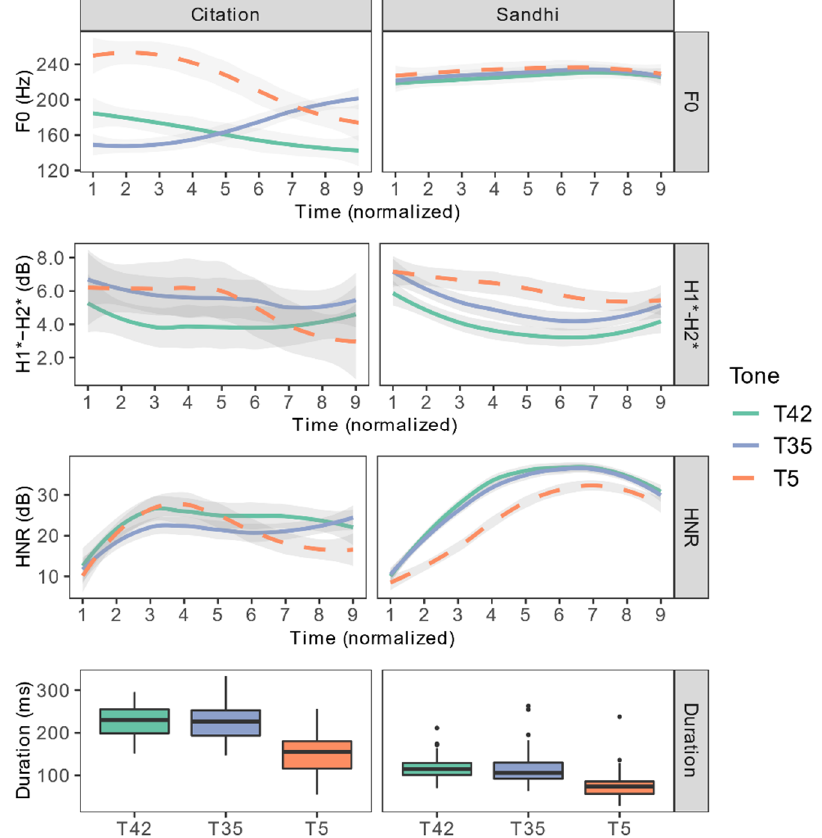
Figure 13. Acoustic parameter values of T42, T35, and T5 in citation and sandhi forms.